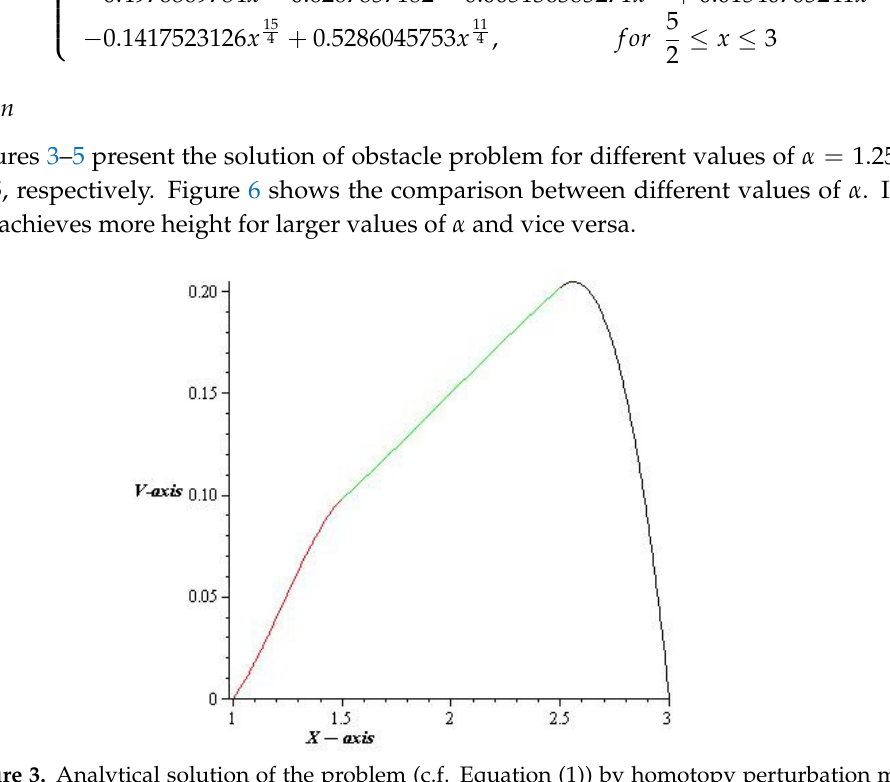
Figure 3. Analytical solution of the problem (c.f. Equation (1)) by homotopy perturbation method (HPM) for α = 1.25.